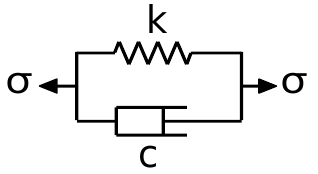
Figure 1. Kelvin-Voigt